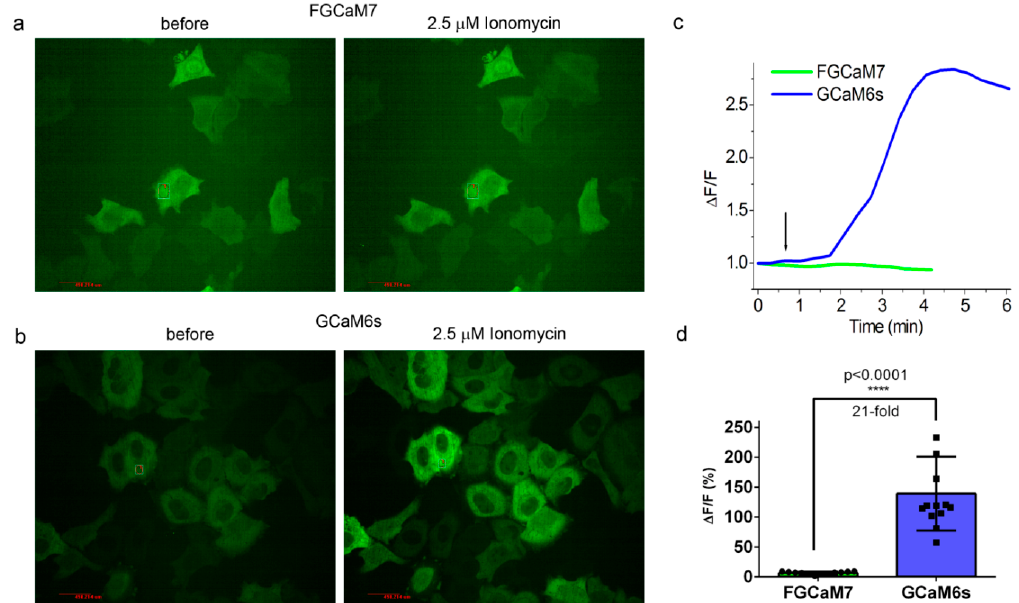
Figure 5. Calcium-dependent response of the truncated versions (with deleted M13-like peptide) of the FGCaMP7 and GCaMP6s indicators in HeLa cells. Confocal images of HeLa cells expressing FGCaM7 ( a ) and GCaM6s ( b ) before and after addition of 2.5 μ m ionomycin. ( c ) Graph illustrating calcium-dependent change in Δ F/F 0 for FGCaM7 (green) and GCaM6s (blue). Addition of 2.5 μ m ionomycin is depicted by black arrow. ( d ) Averaged ionomycin-evoked Δ F/F 0 responses for the FGCaM7 ( n = 12) and GCaM6s ( n = 13) trancated indicators.